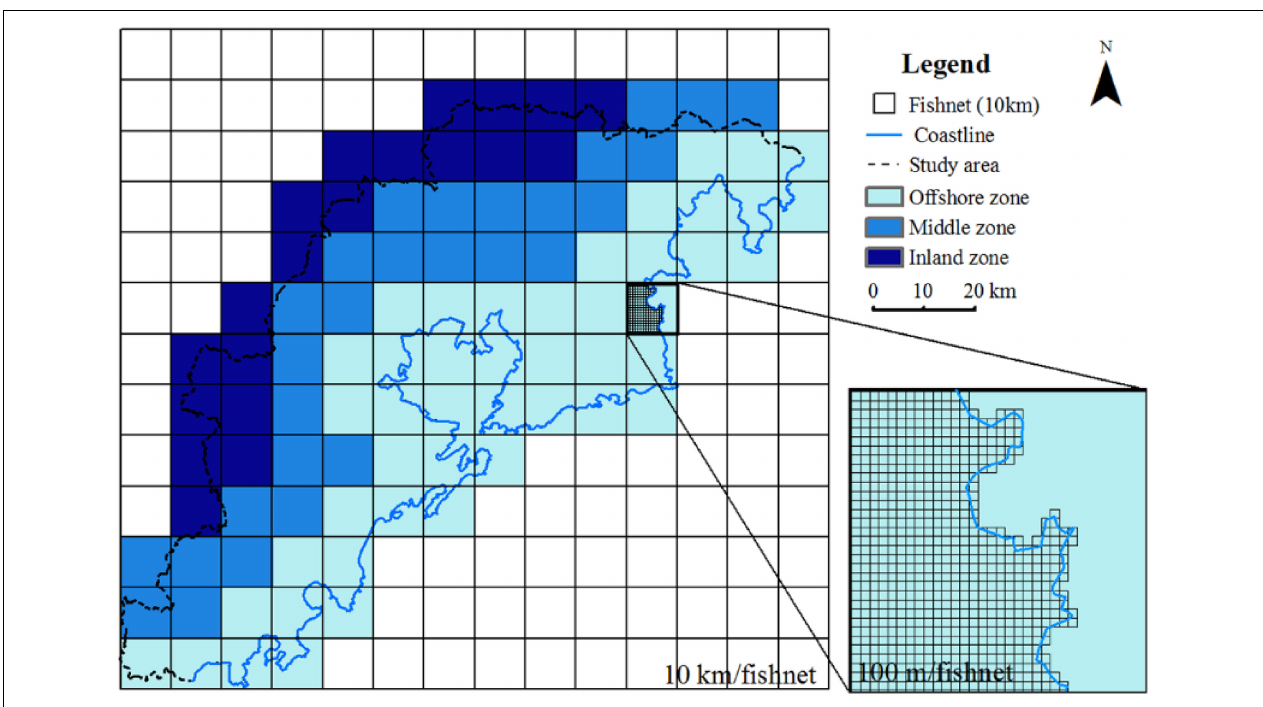
FIGURE 9 | Division of the study area according to the distance from the coastline.